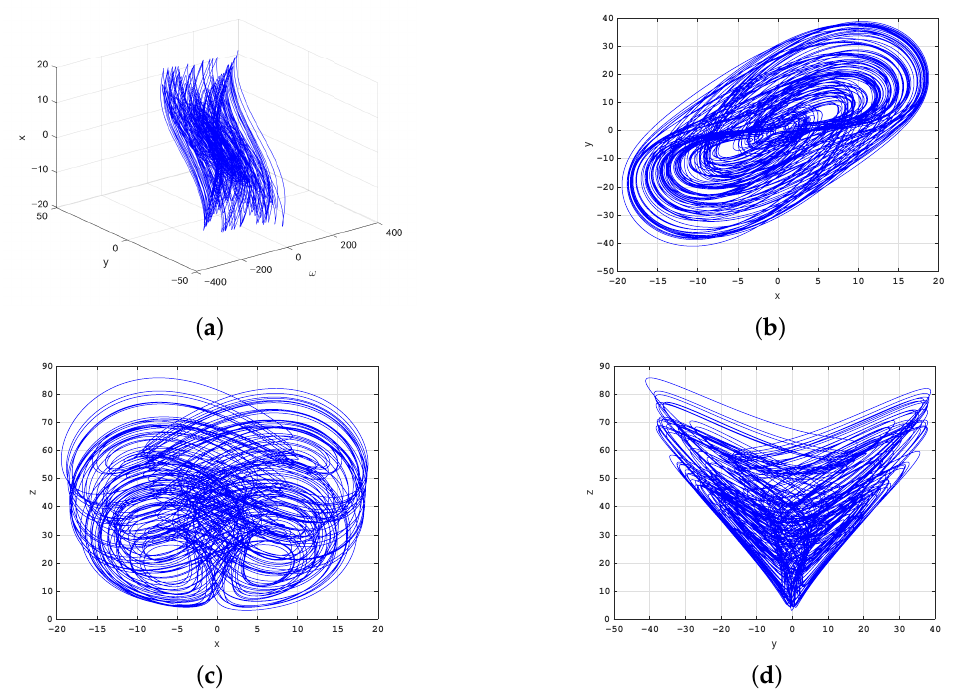
Figure 2. Chaotic attractor phase diagram for the hyper-chaotic Bao-like system based on memristor with the initial condition x ( 0 ) = [ 10,10,10,10 ] T . ( a ) x - y - ω plane. ( b ) x - y plane. ( c ) x - z plane. ( d ) y - z